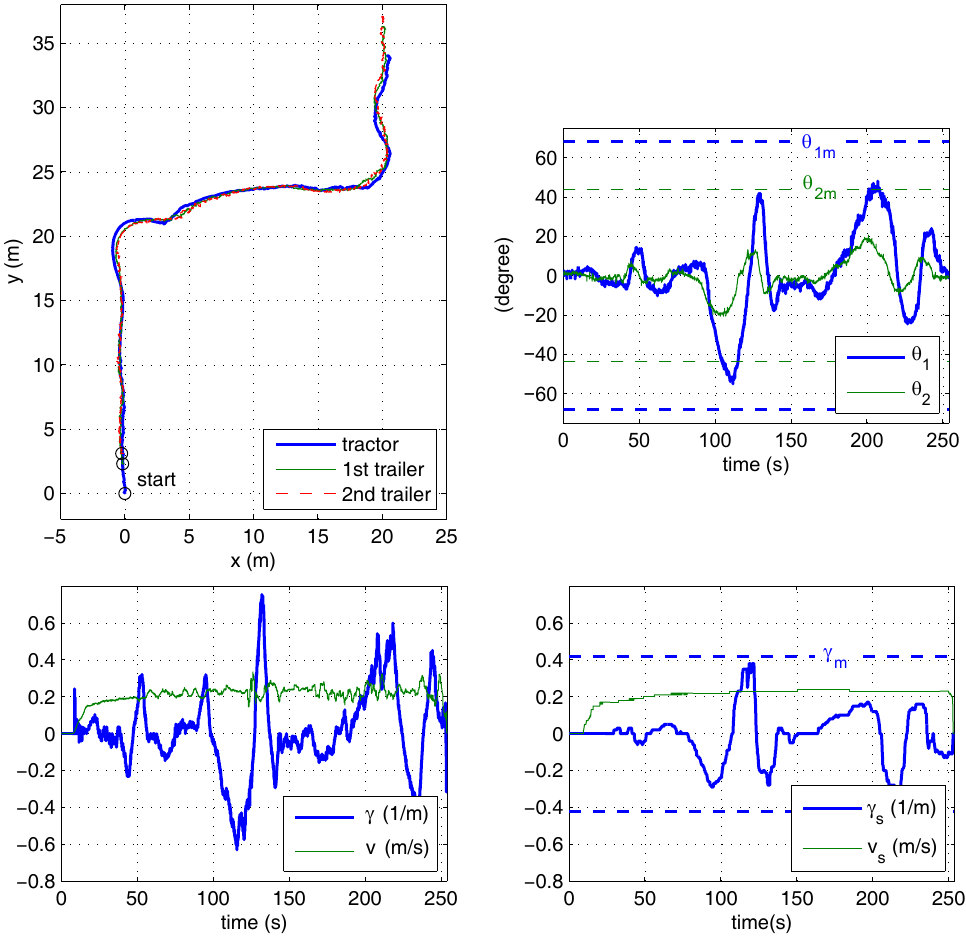
Figure 7. Reverse driving with the off/on axle setup: paths of the tractor and trailers ( top left ); hitch angles with corresponding mechanical limits ( top right ); driver commands and curvature limitations ( bottom right ); speed and curvature of the actual tractor ( bottom left